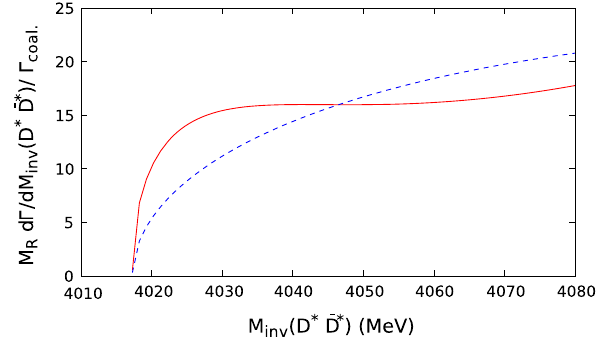
d (cid:8) i Fig. 8 The M R (cid:8) as a function of M in v ( D ∗ ¯ D ∗ ) for the B c → dM inv coal + Z ( 3930 ) decay. The dashed line corresponds to phase space ν l l